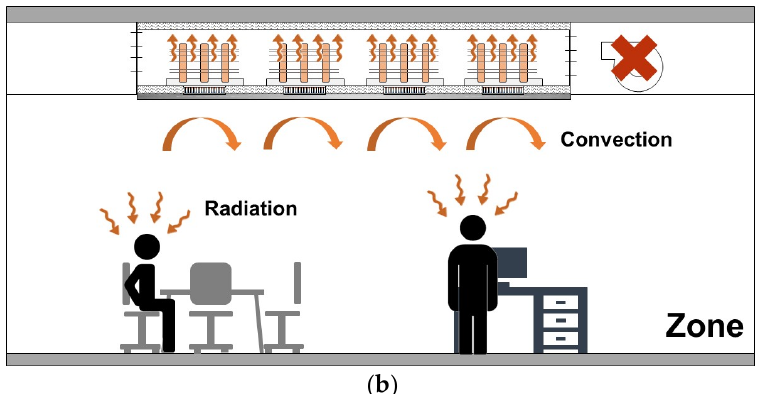
Figure 2. TERP in the heating mode: ( a ) heating mode with fan operation and ( b ) heating mode without fan operation.